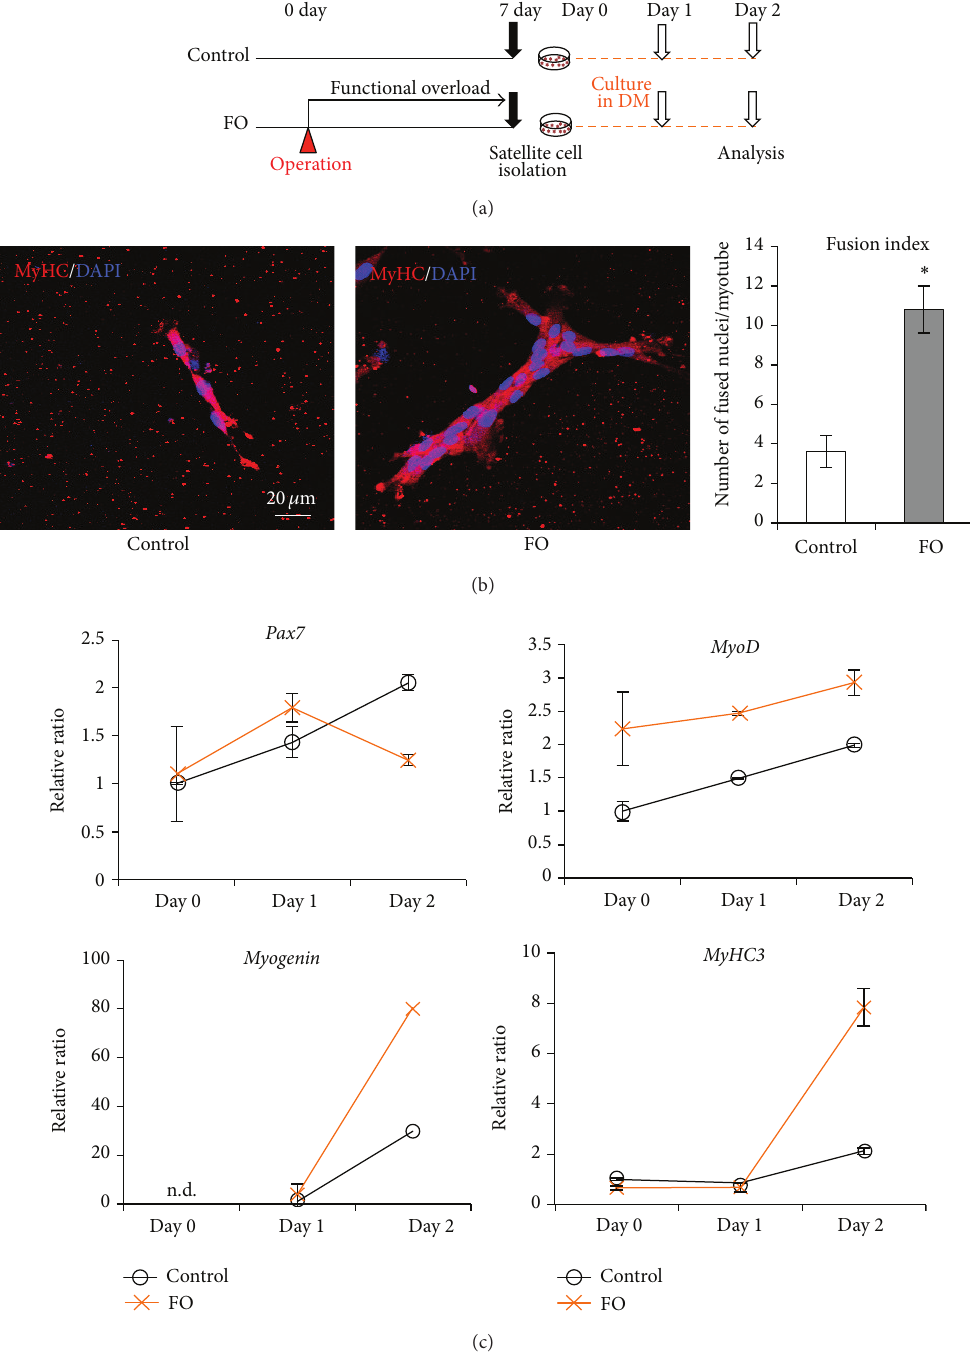
Figure 3: Acceleration of satellite cell differentiation following functional overload. (a) Schematic representation of the experimental design. FO group rats had a surgical operation to ablate synergistic muscles and received functional overload stimulation for 1 week. Satellite cells were isolated from plantaris of each group of rats 7 days after operation and were cultured in differentiation medium for 2 days. (b) Immunocytochemistry analysis of cultivated-satellite cells. Representative merged images of immunocytochemistry staining for MyHC (red) with DAPI from control group (left panel) and FO group (right panel) are shown. Fusion index, calculated to average the number of nuclei fused into a myotube, is shown in the right graph. (c) Expression profiles of stem cell markers in differentiation process of satellite cells. mRNA expression levels of Pax7 (upper left), MyoD (upper right), myogenin (lower left), and MyHC3 (lower right) in cultured cells were measured by qRT-PCR analysis on days 0, 1, and 2 (before and 1 and 2 days after inducing differentiation, resp.). In the graphs, black lines and orange lines represent control group and FO group, respectively. Target mRNA expression was normalized to that of GAPDH and then plotted as the expression ratio relative to the control group. All values are expressed as mean ± SDM (𝑛 = 5) . Significant differences: ∗ compared to control group (𝑃 < 0.05) . n.d.: not